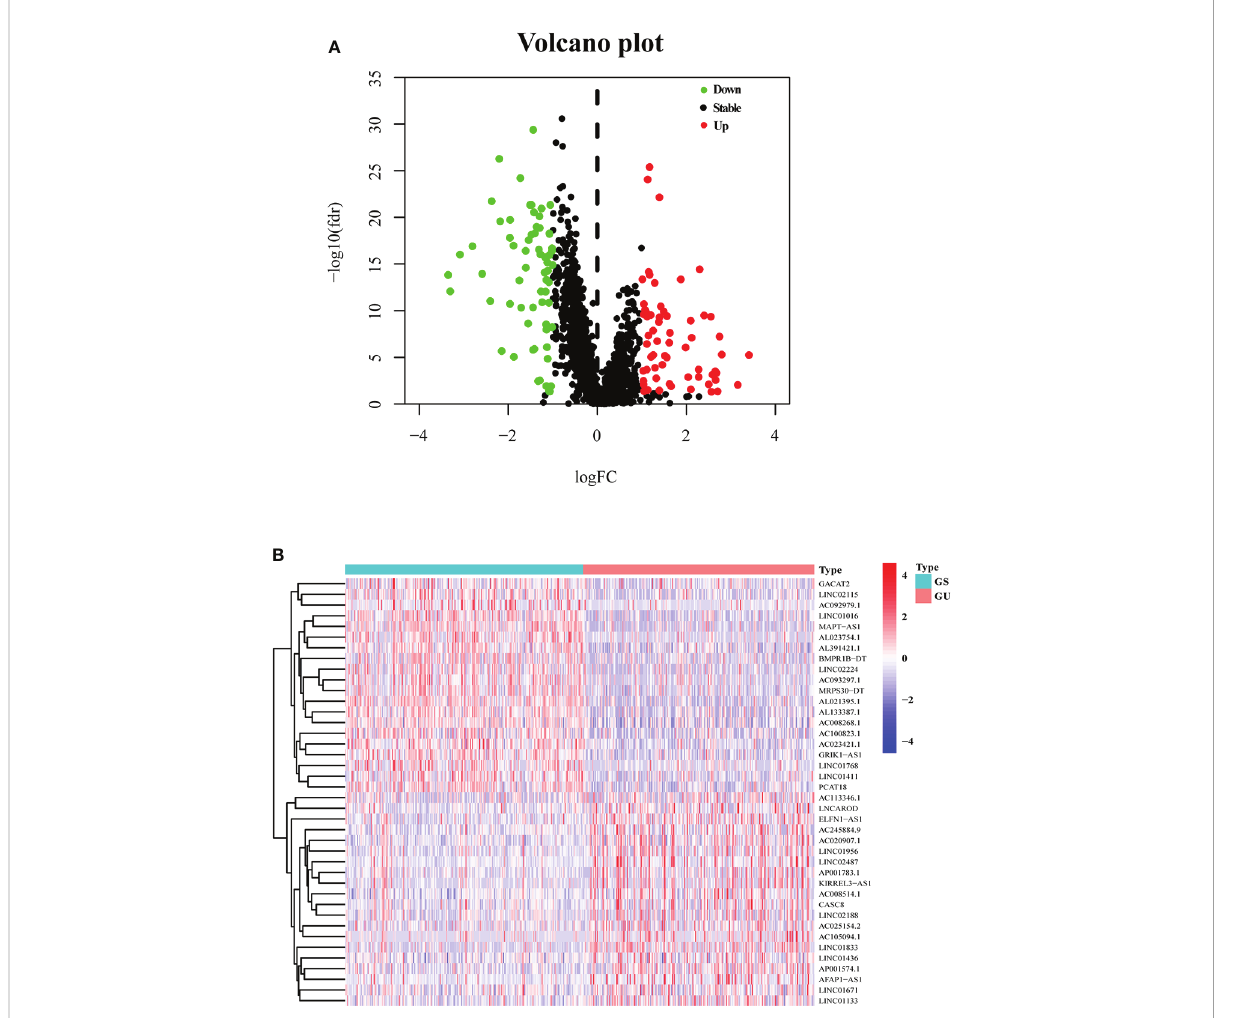
FIGURE 1 One hundred twenty-eight GI-related lncRNAs in breast cancer from TCGA. (A) A total of 128 GI-related lncRNAs are shown in a volcano plot. Sixty-three were upregulated and shown in red. Sixty- fi ve were downregulated and shown in green. (B) Heatmap of the top 20 upregulated and top 20 downregulated GI-related lncRNAs. The top 25% ( n = 252) and the last 25% ( n = 259) mutated patients were selected as GU and GS. The green and red bars represent GU and GS, respectively. Red represents upregulated lncRNA, and blue denotes downregulated